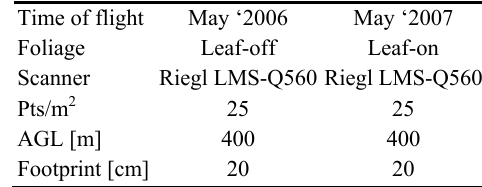
Table 2 Configurations for two airborne LiDAR campaigns